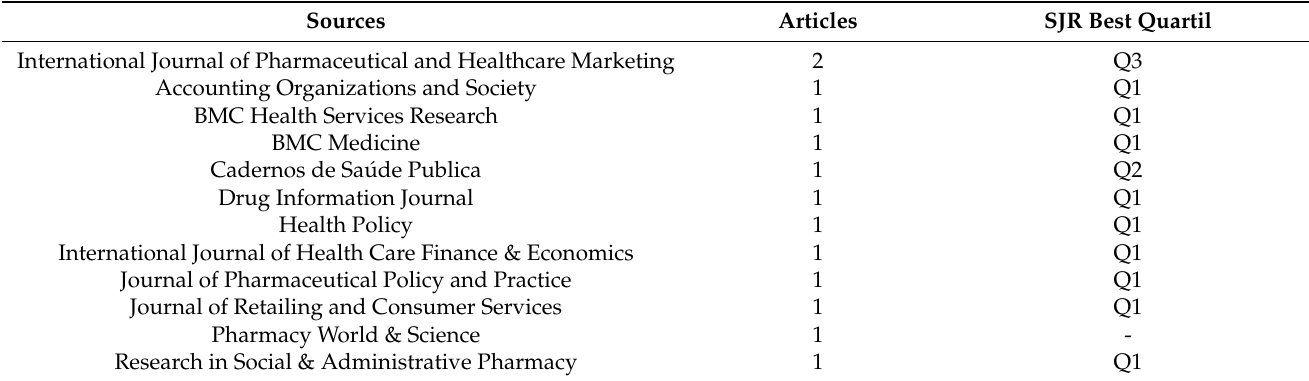
Table 3. Journals that form the research corpus.